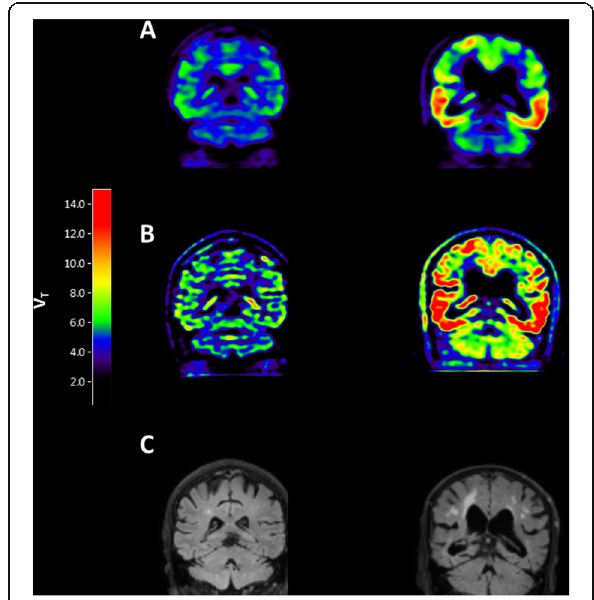
Fig. 1 Coronal [ 18 F] flortaucipir V T images before ( a ) and after ( b ) HDH PVC and coronal MR flair ( c ) in a healthy control (left) and probable AD patient (right)